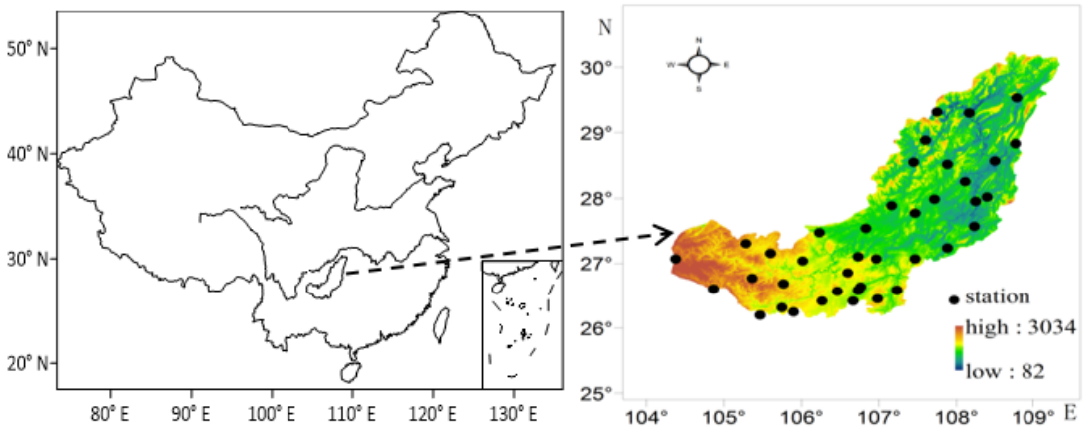
Figure 1. Locations of 42 meteorological stations (dots) in the Wujiang River Basin in China.